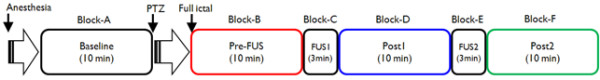
Flowchart of the EEG acquisition and FUS sonication. Block-A represents the baseline period. The baseline EEG was recorded for ten minutes after the EEG signals stabilized following the administration of anesthesia. Block-B (named as 'Pre-FUS') indicates the time-interval after observing significant evidence of ictal behavior (e.g., bilateral forepaw-twitches) and just before the first sonication. Block-C represents the three-minute period of the first sonication (named as 'FUS1'), and Block-E represents the second three-minute sonication interval (named as 'FUS2'). Block-D represents the time-interval after the first sonication (named as 'Post1'), and Block-F represents the time-interval after the second sonication (named as 'Post2').